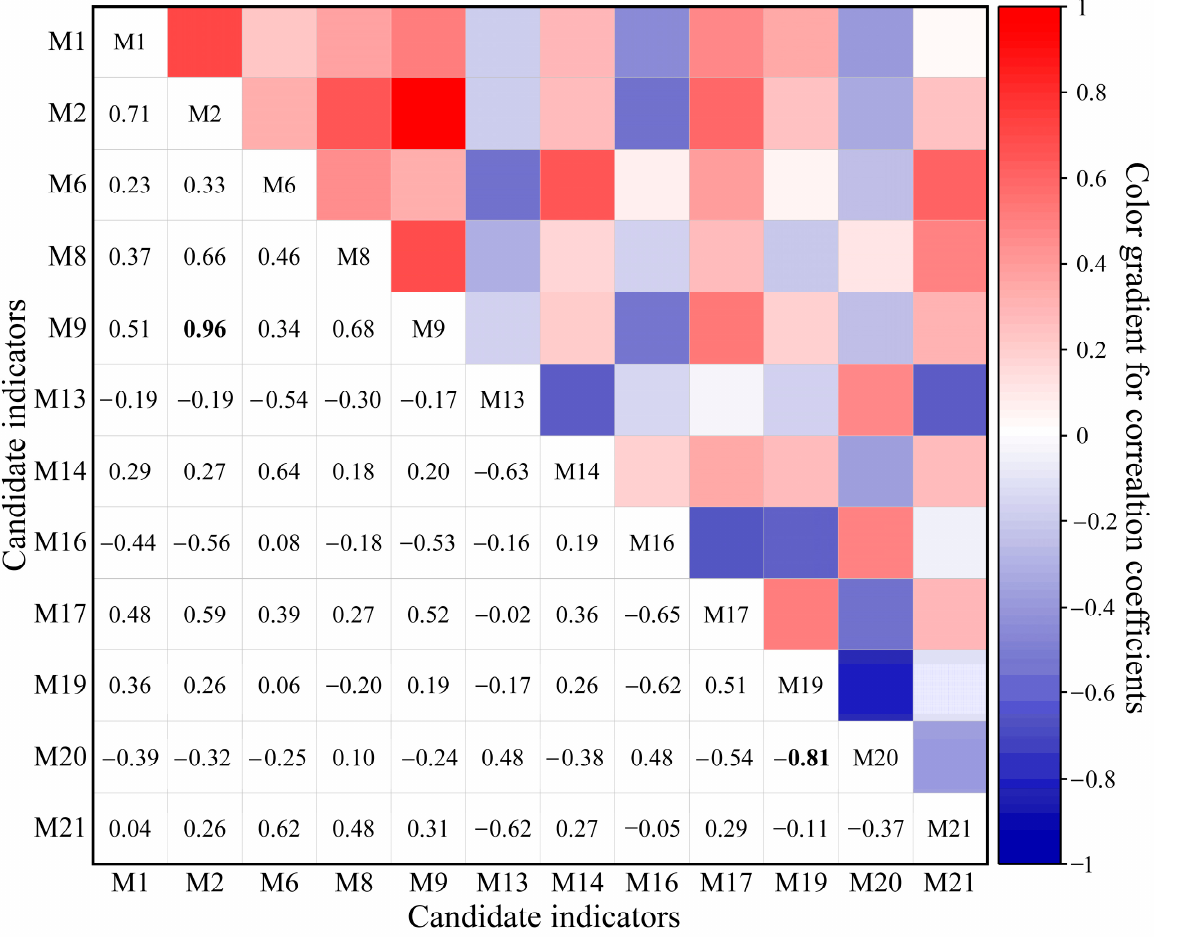
Figure 8. Spearman related analysis results between the 12 candidate indicators.